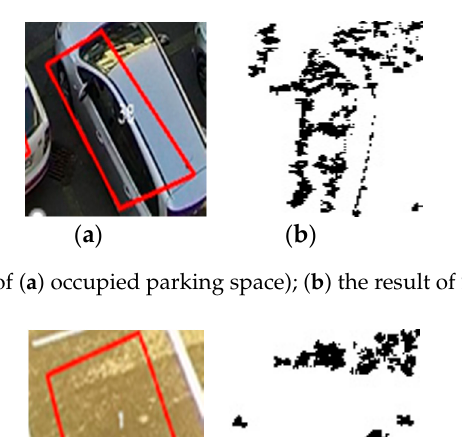
Figure 5. The image of ( a ) sunny parking space; ( b ) the result of SIFT corner detector.